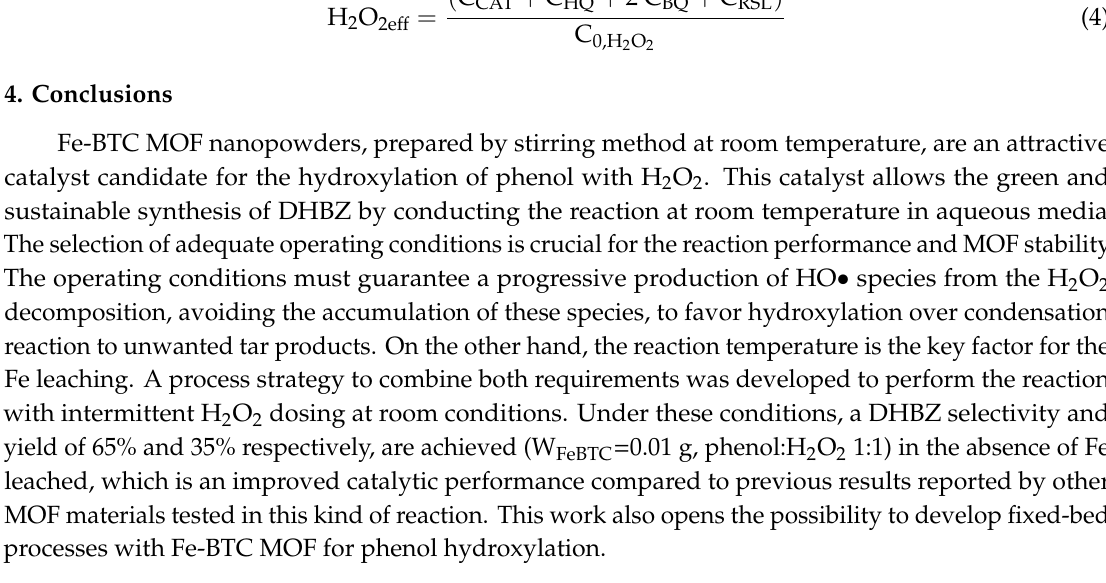
Figure S1. DSC curves of Fe-BTC before (fresh) and after reaction (used), Figure S2. Adsorption isotherm of N 2 , inset: micropore size distribution by BHJ method of Fe-BTC after reaction